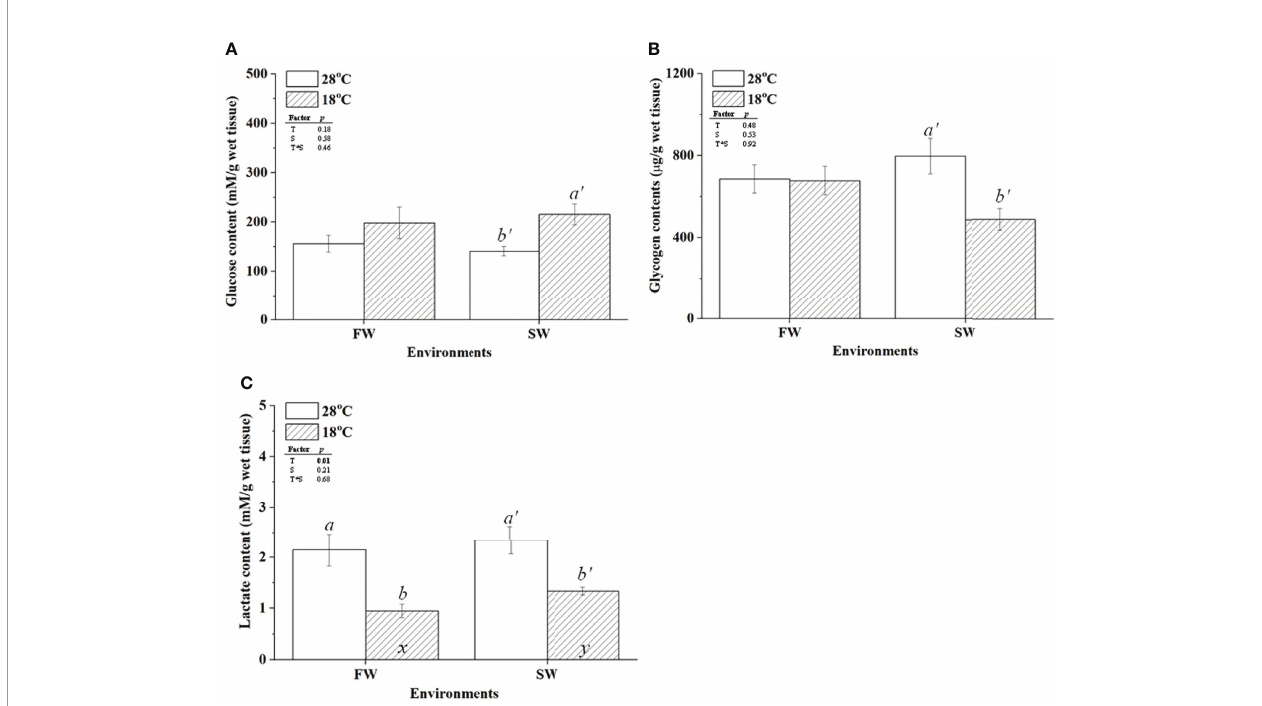
FIGURE 3 | The contents of glucose (A) , glycogen (B) , and lactate (C) in freshwater (FW) and seawater (SW)-acclimated milk fi sh at 28°C (white bar) and 18°C (striped bar). Different letters in the FW milk fi sh (a, b) and SW milk fi sh (a ’ , b ’ ) indicate signi fi cant differences between the normal and low-temperature groups. The x and y indicate signi fi cant differences between the FW and SW groups at 28°C or 18°C. Values represent the mean ± standard error of the mean (SEM), n = 9, P <